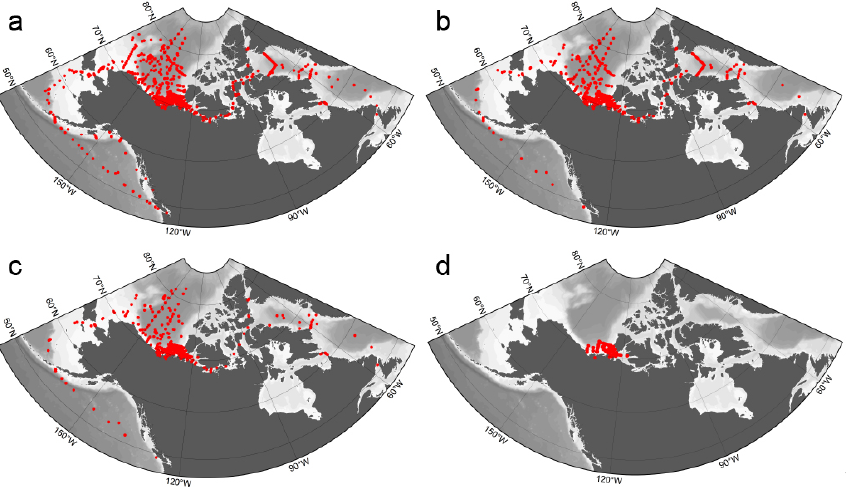
Figure 1. Map of (a) all stations included in the data set, and (b–d) all stations in the data set that include measurements of (b) alkalinity, (c) DIC, or (d)